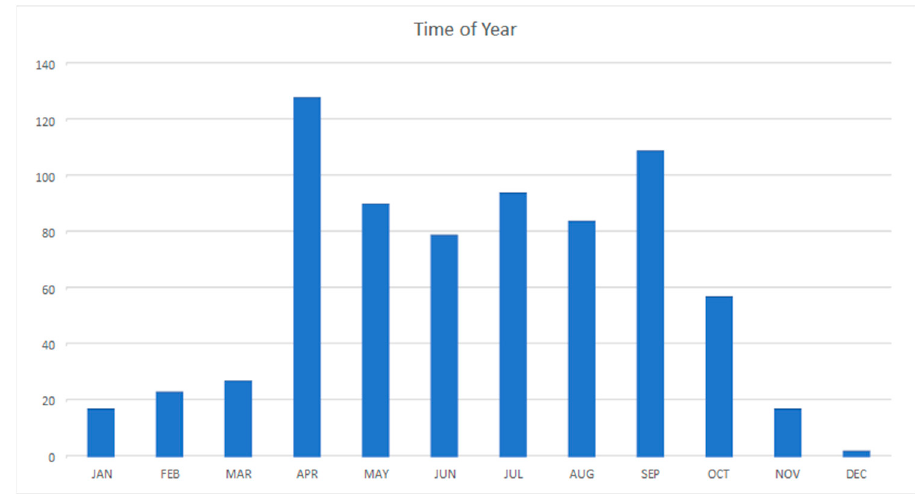
Figure 4. Seasonal cycle of Virginia tornadoes.